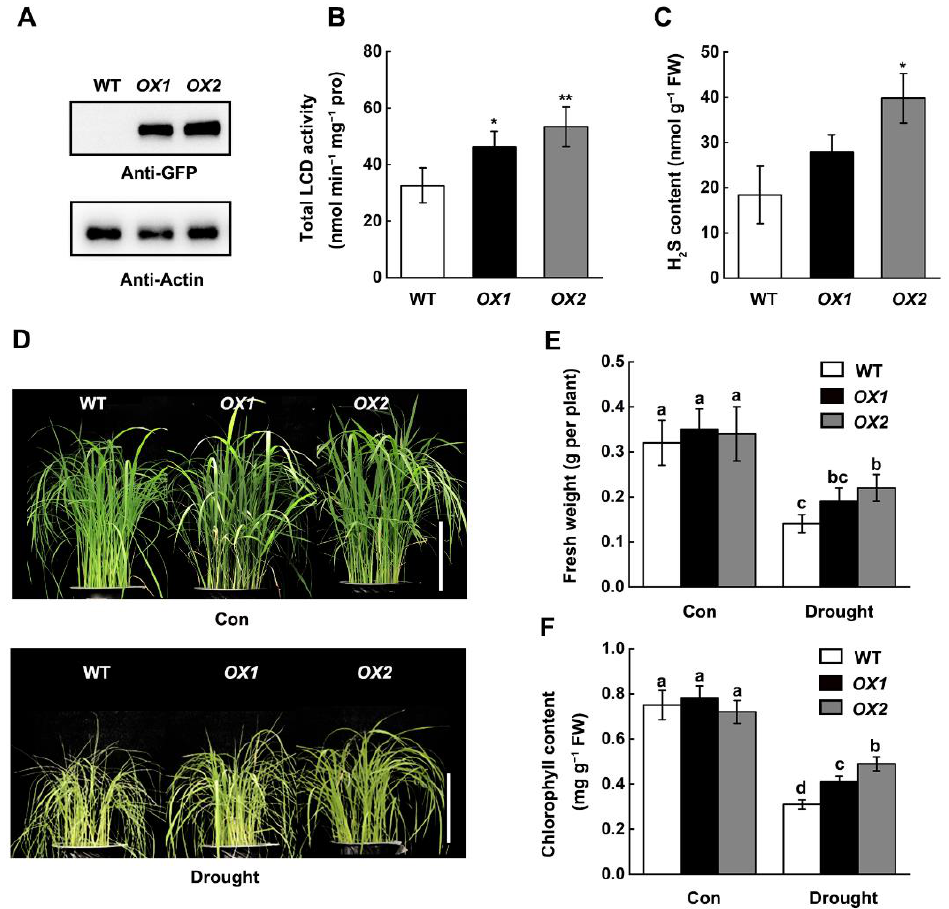
Figure 3. Overexpression of OsLCD1 enhances rice drought tolerance. ( A ) Identification of 35S:OsLCD1-GFP overexpression lines. The total protein from two independent overexpression lines ( OX1 and OX2 ) and wild-type (cv. Wuyunjing 7, WT) was extracted and was analyzed by immunoblotting with an anti-GFP antibody. ( B , C ) Overexpression of OsLCD1 increases LCD activity and H 2 S production in 14-day-old rice plants. ( D ) Drought stress tolerance assay. Well-irrigated 14-day-old wild-type, OX1 , and OX2 rice seedlings were exposed to drought stress by withholding water for 6 days. Pictures were then taken. Scale bar = 10 cm. ( E , F ) The related fresh weight and chlorophyll content were determined. Data are means ± SD ( n = 3). Statistical comparisons were performed by independent samples t -test (two-tailed) between leaves from wild-type and OsLCD1 overexpression lines (* p < 0.05, ** p < 0.01). Different lower case letters indicate significant differences at p < 0.05 (one-way ANOVA, Duncan’s multiple range